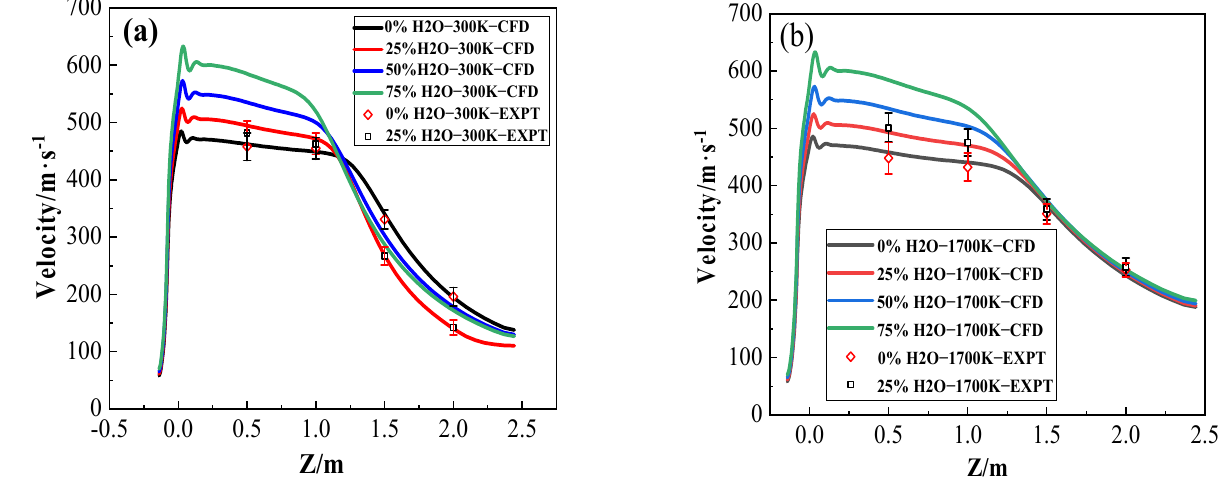
Figure 5. The axial velocity distribution on the centerline of coherent supersonic jet. ( a ) The velocity measured by numerical simulations and experimentally at 300 K. ( b ) The velocity value measured by numerical simulations and experimentally at 1700 K.